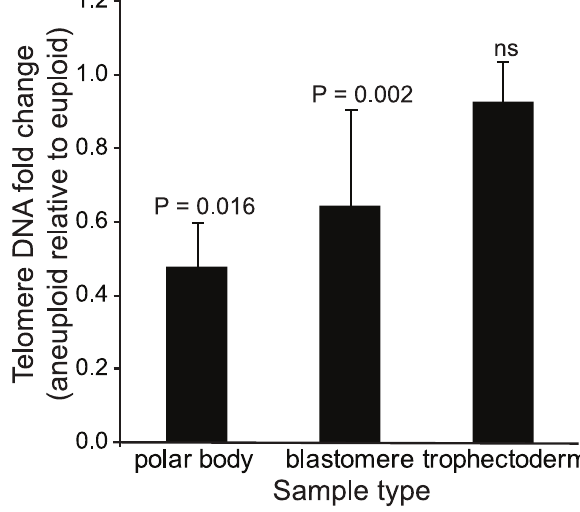
Figure 3. Mean quantities ( ± SEM) of telomere DNA found in aneuploid relative to euploid polar bodies, blastomeres, and trophectoderm biopsies. P -values from paired analysis of sibling samples within each patient are shown and illustrate the significant decrease in relative quantity in aneuploid polar bodies and blastomeres but not